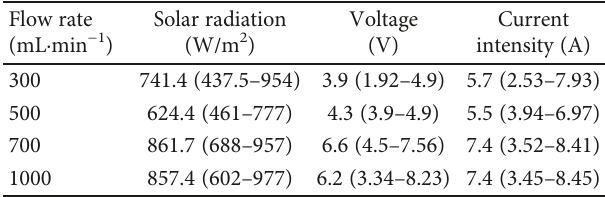
Table 4: Evaluated parameters during di ff erent RYD fl ow